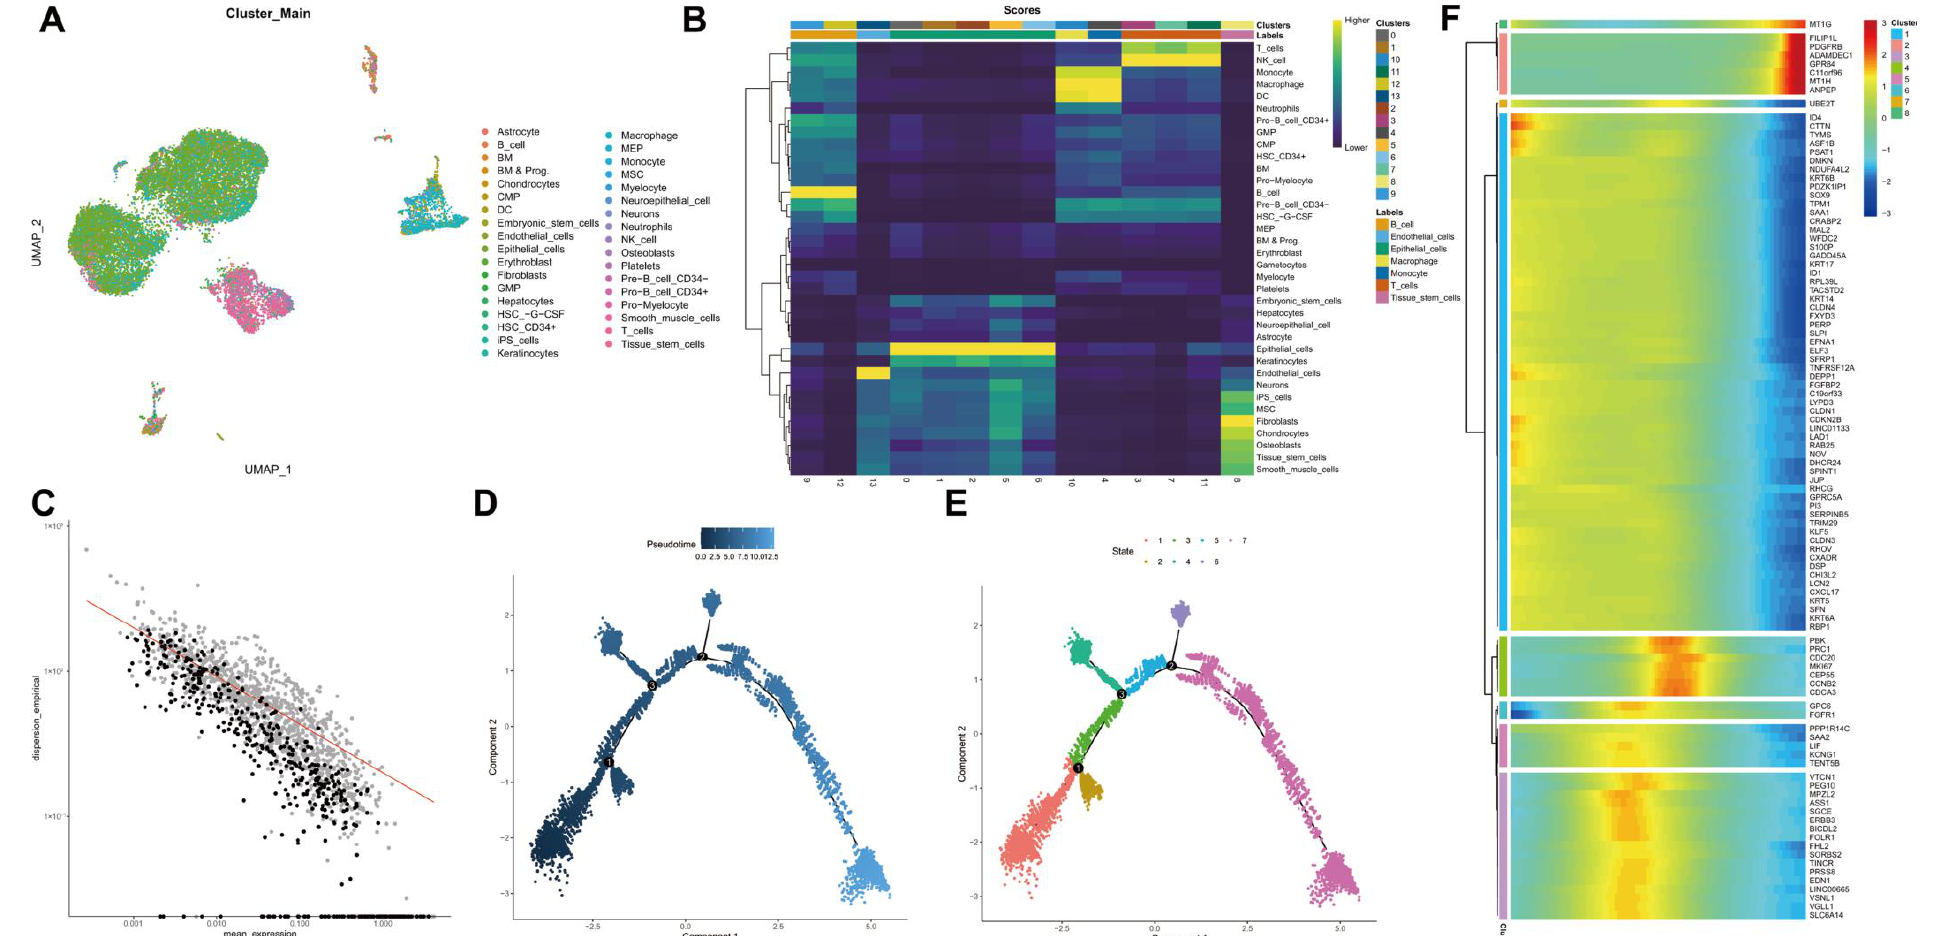
Figure 3. scRNA-seq data from human TNBC tissue samples are subjected to UMAP cluster analysis and trajectory analysis. ( A ): Cell types following UMAP cluster analysis; ( B ): Cell clusters are annotated into seven cell types using the R “SingleR” package; ( C ): Order gene visualization results; ( D ): Cell evolution trajectory display according to pseudotime. Color from dark to light indicates “time” proceeding; ( E ): Cell evolution trajectory display according to differentiation stage. Different colors represent different cell clusters; ( F ): A heat map showing the expression of the top 100 driver genes. The color change in the central indicates gene expression